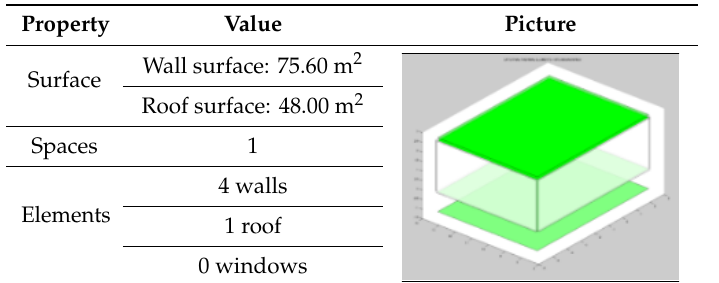
Table 7. Description of the case study.